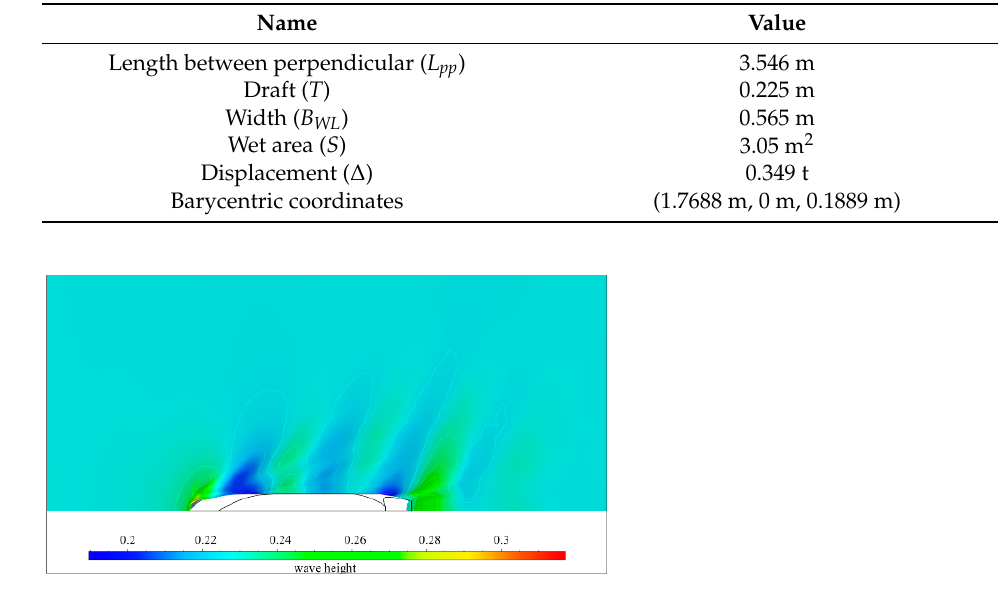
Table 9. Main parameters of traditional icebreaker ship model (scale ratio α = 40).